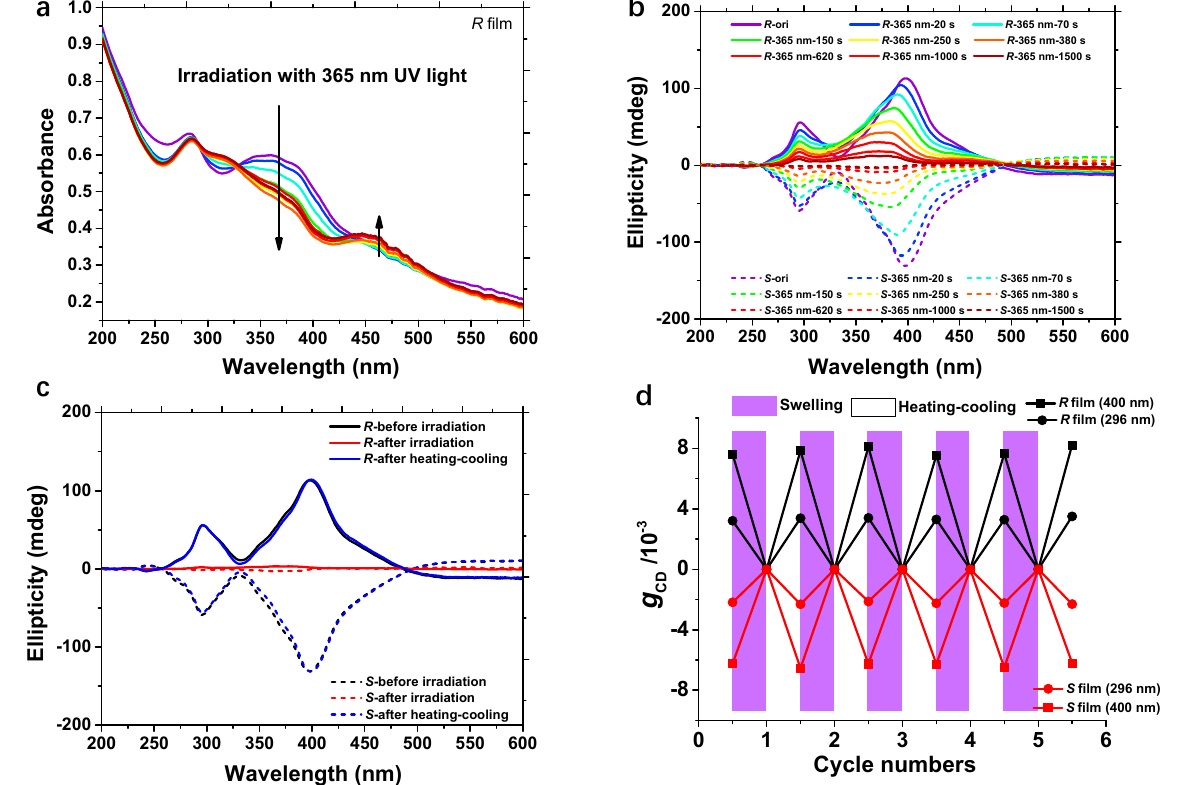
Figure 6. ( a ) Changes in UV-vis spectra of the cross-linked chiral polymer films under irradiation with 365 nm light. ( b ) Changes in CD spectra of the cross-linked chiral polymer films (induced by PB- R / S 1) during 365 nm light irradiation. ( c ) Self-recovery of CD signals of the irradiated chiral films during the heating–cooling process. ( d ) Construction of chiroptical switch without chiral resource: destruction and chiral self-recovery behavior: switches of the cross-linked films during the above process (as shown by g CD values, calculated from Figure S15).